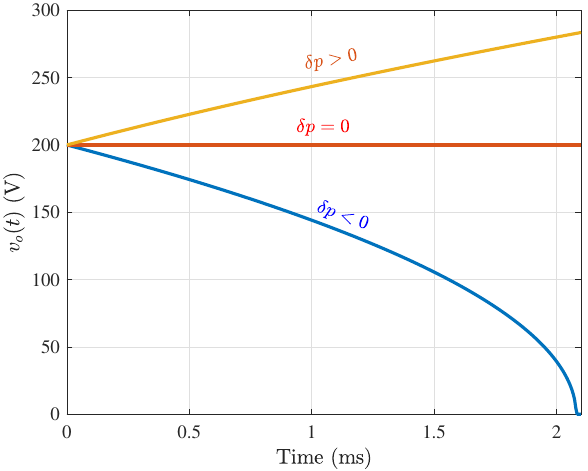
Figure 4. Response of the nonlinear electrical network of Figure 3. C = 20.8 µ F. v o [ 0 ] = v g = 200 V.